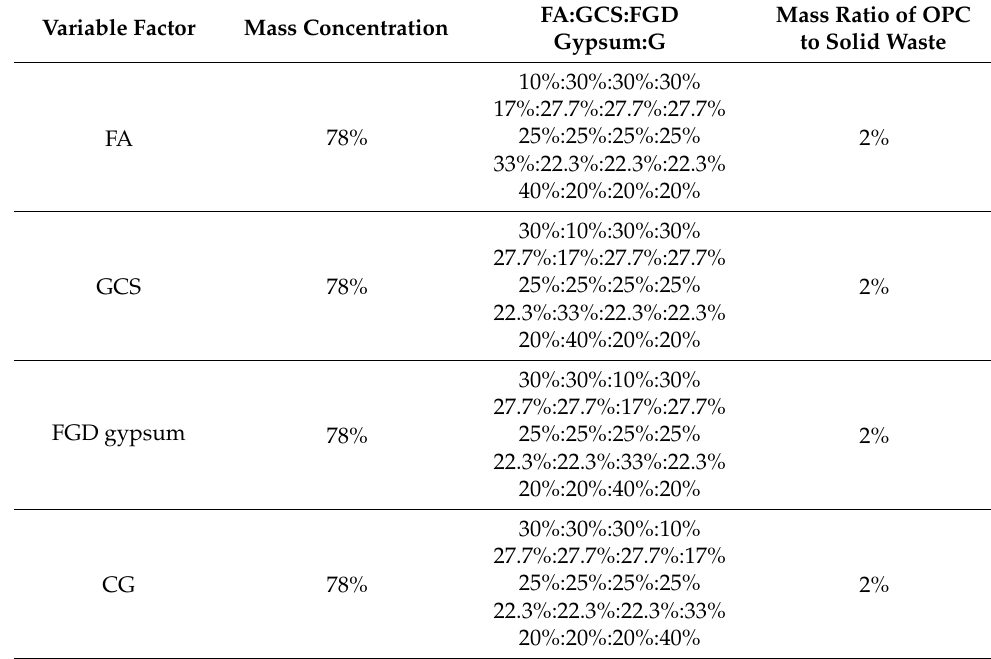
FA:GCS:FGD Mass Ratio of